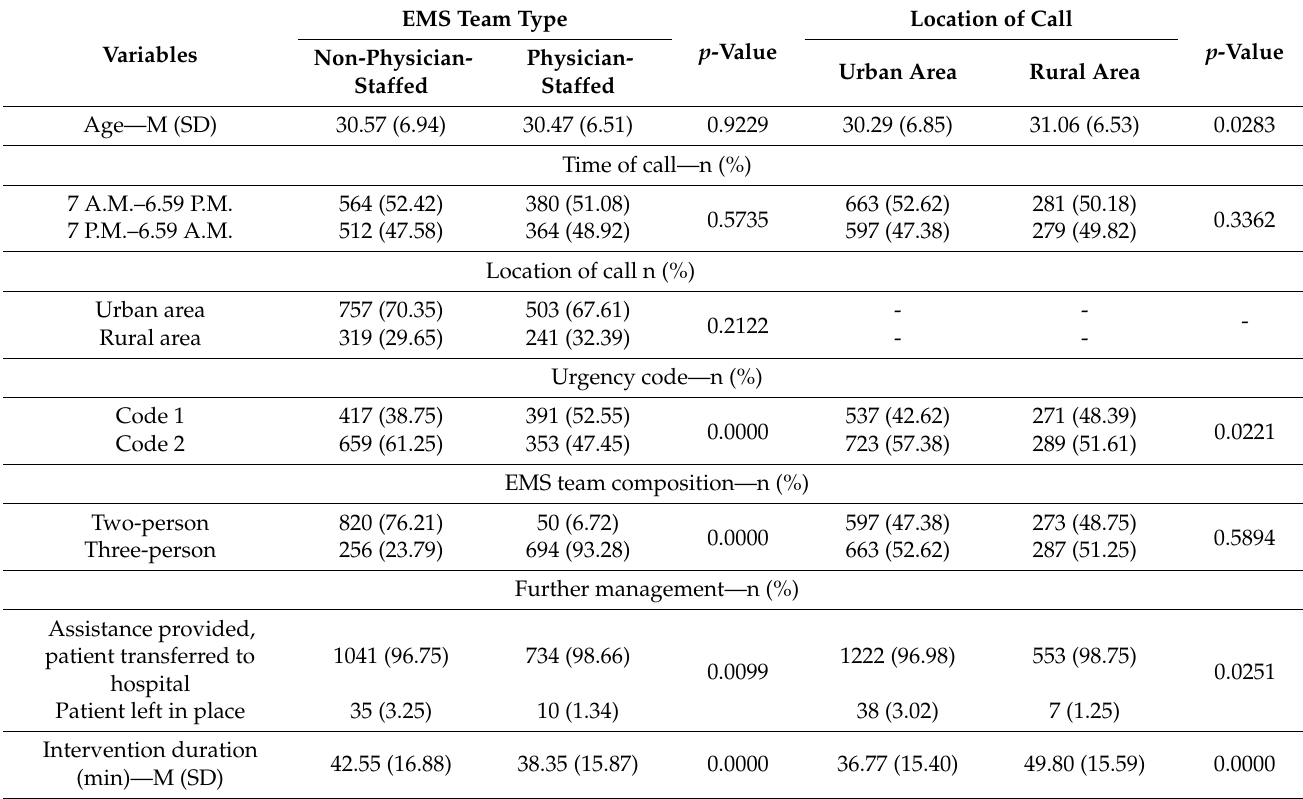
Table 3. Analysis of the relationship between EMS team type and call location, and selected variables.